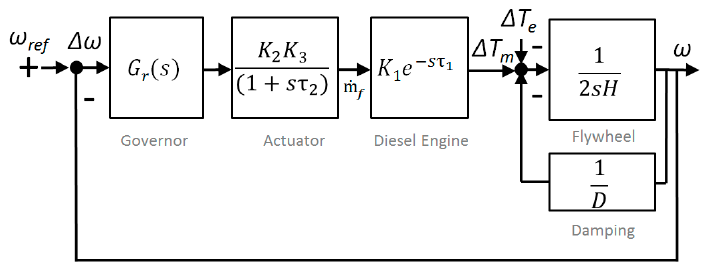
Figure 7. Diesel engine—Governor model [40].